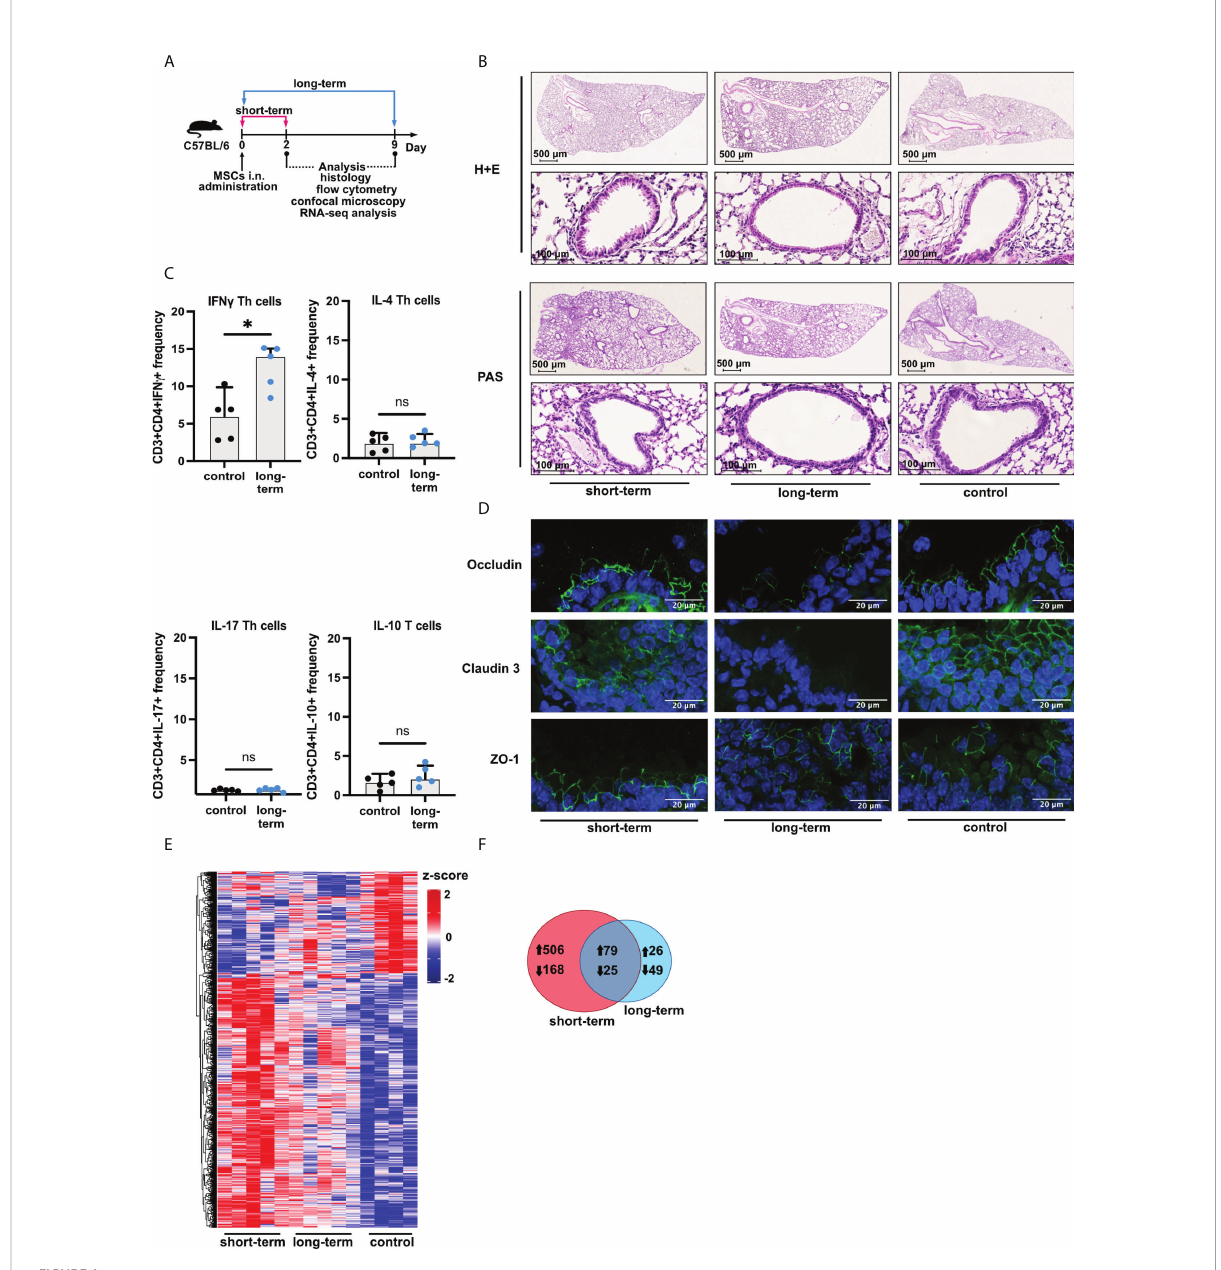
FIGURE 1 Induction of low-grade in fl ammation is a long-term effect of intranasal administration of adipose-tissue-derived mesenchymal stem cells. (A) Experimental mice model used in the study. Female C57BL/6 mice were sacri fi ced directly after two days (short-term), and nine days (long- term) after mesenchymal stem cells (MSCs) intranasal ( i.n. ) administration. Saline (vehicle)-treated mice were used as control. (B) Representative Hematoxylin & Eosin (H&E) and Periodic Acid-Shiff (PAS) staining in the lung sections. (C) Summary of fl ow cytometry analyses of IFN g , IL-4, IL-17, or IL-10 producing T cell frequency after MSCs administration in the long-term model. U Mann-Whitney test was used to evaluate differences between groups, *p < 0.05; ns, not signi fi cant; n=5. (D) Representative confocal staining of occludin, claudin 3, and zonula occludens-1 (ZO-1) in the alveoli after MSCs i.n. administration; DAPI – blue; green – positive signal for analyzed proteins. (E) Summary of transcriptomic pro fi les of the lung after MSCs i.n. administration. The heatmap shows all (n =853) differentially regulated genes (DEGs) among the analyzed groups. DEGs were identi fi ed based on |Log2FoldChange| > 0.5, and adjusted p value < 0.1. Cutoffs were applied with matched HGNC identi fi ers. Complete linkage clustering was applied. (F) Venn diagram of differentially and commonly regulated genes in the short- (marked red) and long-term model (marked blue). Arrows indicate the up- or down-regulated expression of